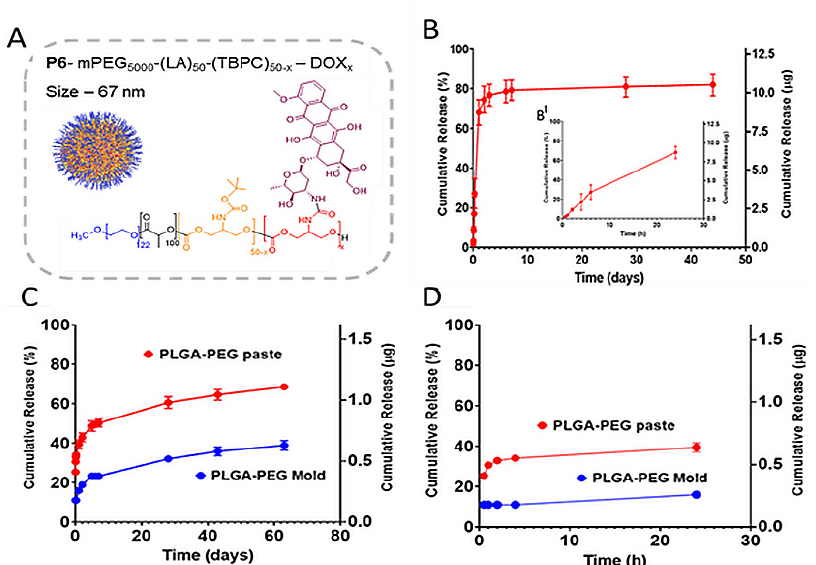
Figure 7. ( A ) P6-mPEG 5000 -(LA) 50 -(TBPC) 50 − x -DOX x formulation, showing average size obtained for each of the in vitro experiments carried out in this body of work. ( B(B I )) . Cumulative% and µg of DOX release from the DOX-loaded NPs over 44 days ( B ) and 24 h ( B I ). ( C , D ). Release was carried out in PBS. Time points represent one independent repeat ( n = 3) with error bars showing the mean ± one SD. Cumulative% and µg of DOX-NP release from the PLGA/PEG microparticulate matrix over 63 days ( C ) and 24 h ( D ). Release was carried out in PBS. Time points represent one independent repeat ( n = 3) with error bars showing mean ± one